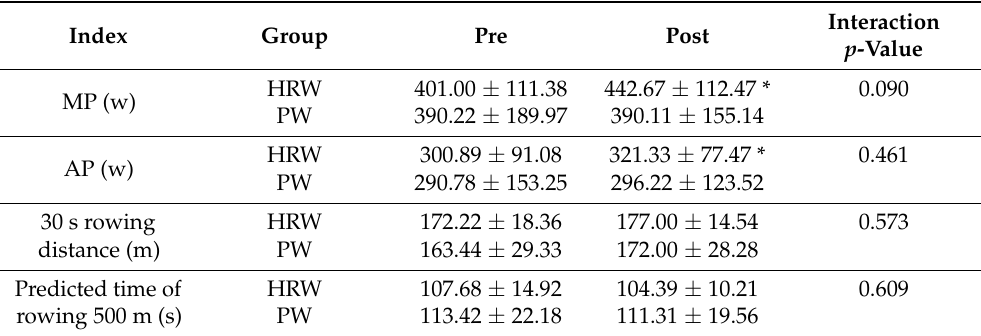
Table 2. Performance in 30 s rowing test before and after the intervention within the HRW and PW groups.